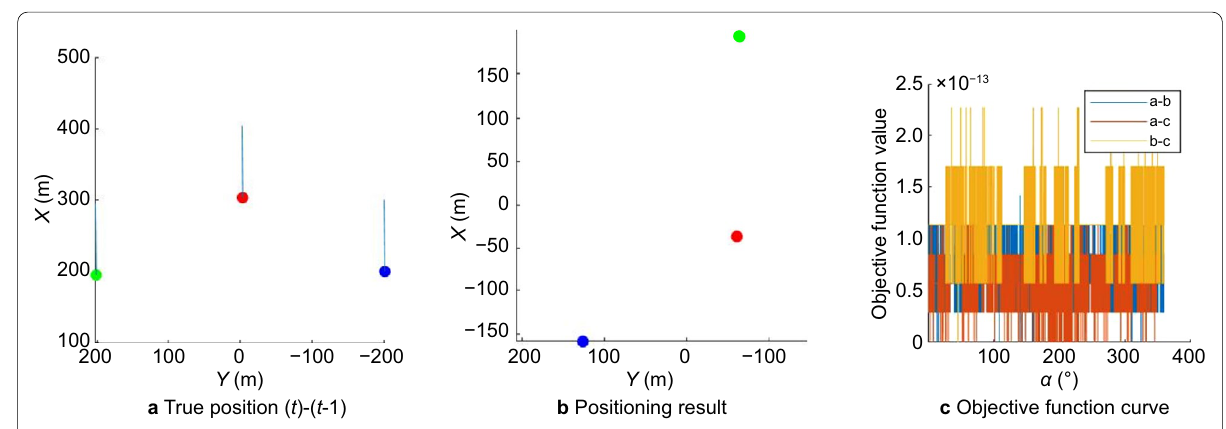
Fig. 8 Parallel formation (constant velocity) scenario, simulation results at time t =